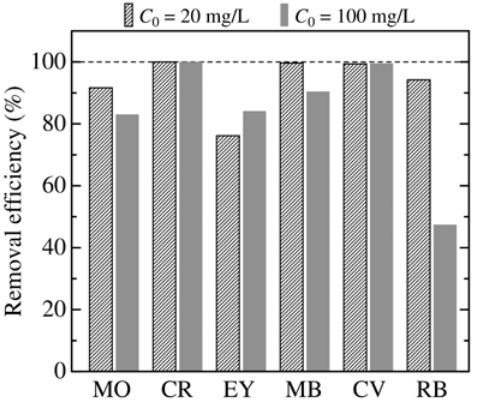
Figure 13. Removal efficiency of the DA5 sample for various anionic (MO, CR and EY) and cationic (MB, CV and RB) dyes at different initial concentrations (dosage = 0.5 g/L, temperature = 301 K).